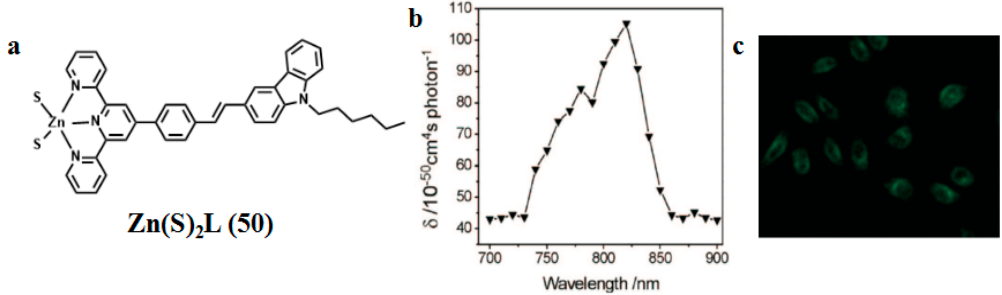
Figure 7. ( a ) The structure of 50 ( b ) Two-photon (200 fs, 76 MHz Ti: sapphire laser) absorption cross section ( δ ) of 50 in DMF versus excitation wavelengths with 380 mw power ( c ) 2PEF image of HeLa cells with excitation at 800 nm.